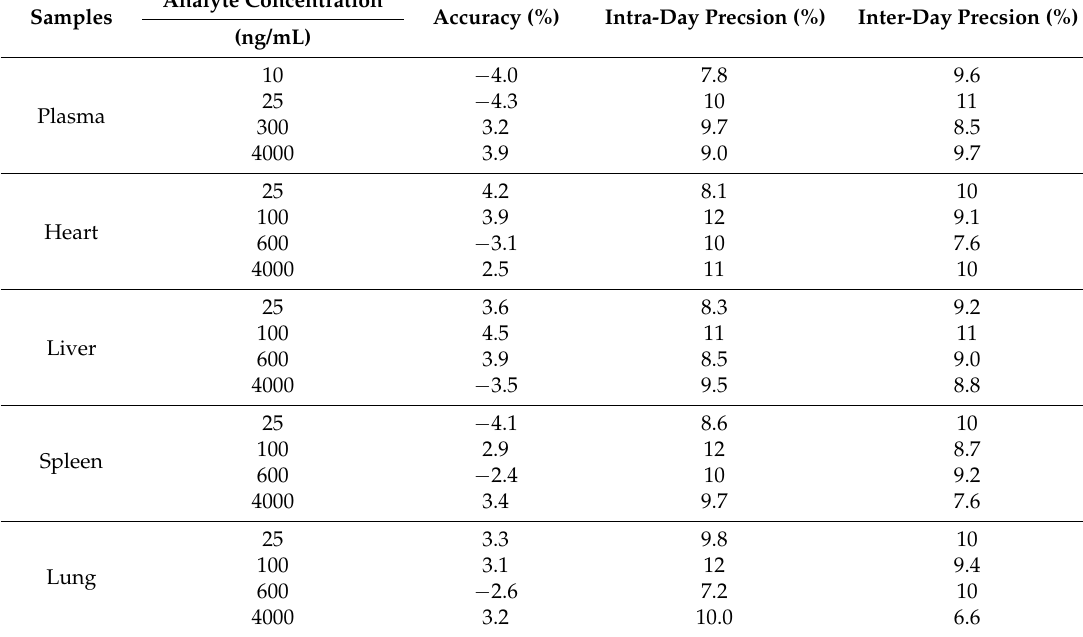
Table 2. Precision and accuracy of the determination of the analytes in rat biological samples (n = 6).